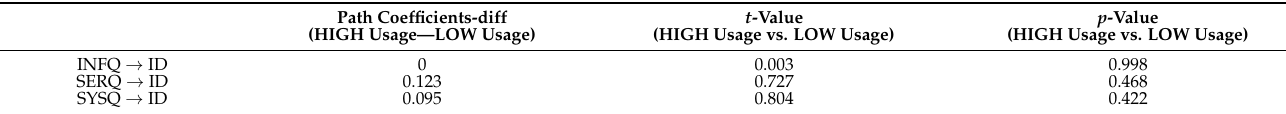
Table 7. Results of the parametric